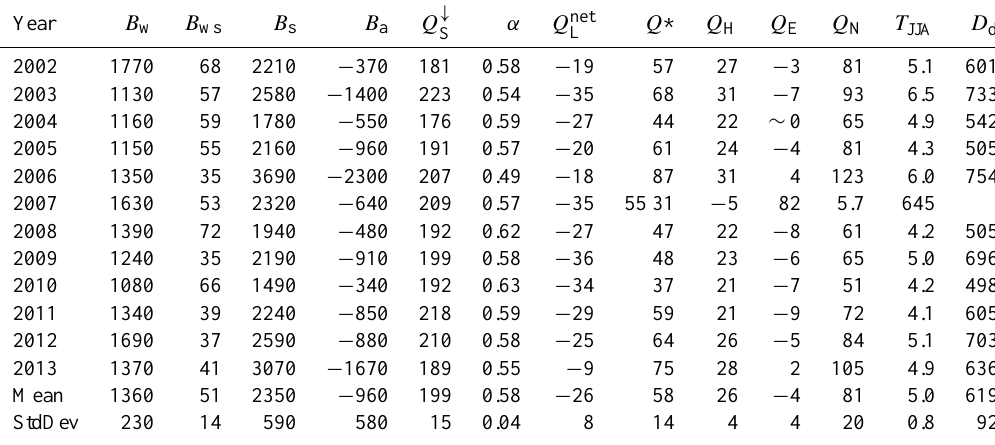
Table 6. Modelled surface mass balance and summer (JJA) surface energy balance at Haig Glacier, 2002–2013. B w is winter (October to May) snow accumulation; B ws is the summer snow accumulation; B s is summer (May to September) ablation; B a is the annual (net) surface mass balance. Energy fluxes are in Wm − 2 and mass balances are mean specific values (mmw.e.), T JJA is the mean glacier JJA temperature ( ◦ C) and D d is May–September positive degree days ( ◦ Cd).